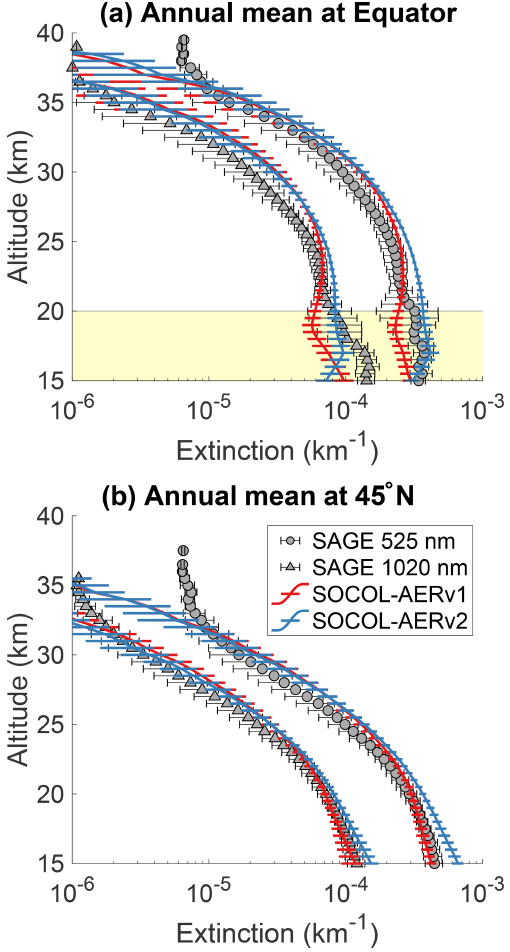
Figure 3. Comparison between annual mean model extinctions at 525 and 1020nm and SAGE II measurements from the GloSSAC project (Thomason et al., 2018) at the Equator (a) and 45 ◦ N (b) . Observations are averaged between 2000 and 2004, representing the volcanically quiescent part of the record. Model results are av- eraged over 5 years of the year 2000 time slice for SOCOL-AERv1 and SOCOL-AERv2. Horizontal bars represent the modeled or ob- served standard deviation. The highlighted region in the upper plot corresponds to the altitudes where nonsulfate aerosols may play a